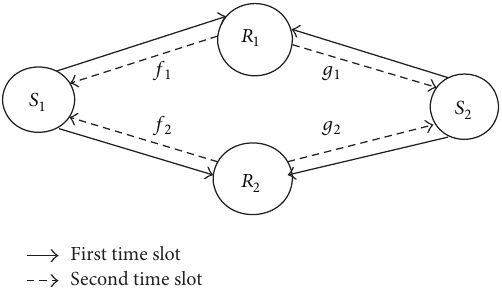
Figure 1: Transmission model of